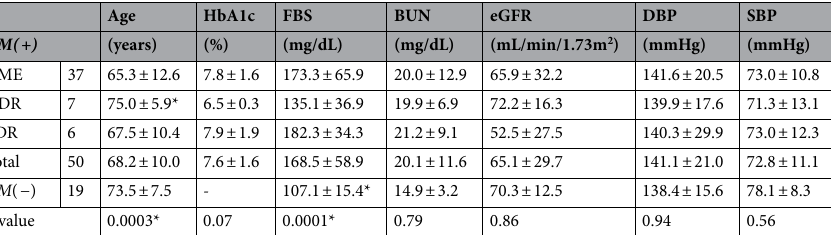
Table 1. Demographics of all patients. BUN: blood urea nitrogen, DBP: diastolic blood pressure, DM: diabetes mellitus, DME: diabetic macular edema, eGFR: estimated glomerular filtration rate, FBS: fasting blood sugar, HbA1c: hemoglobin A1c, NDR: no diabetic retinopathy, PDR: proliferative diabetic retinopathy, SBP: systolic blood pressure. *: P < 0.05, Kruskal–Wallis